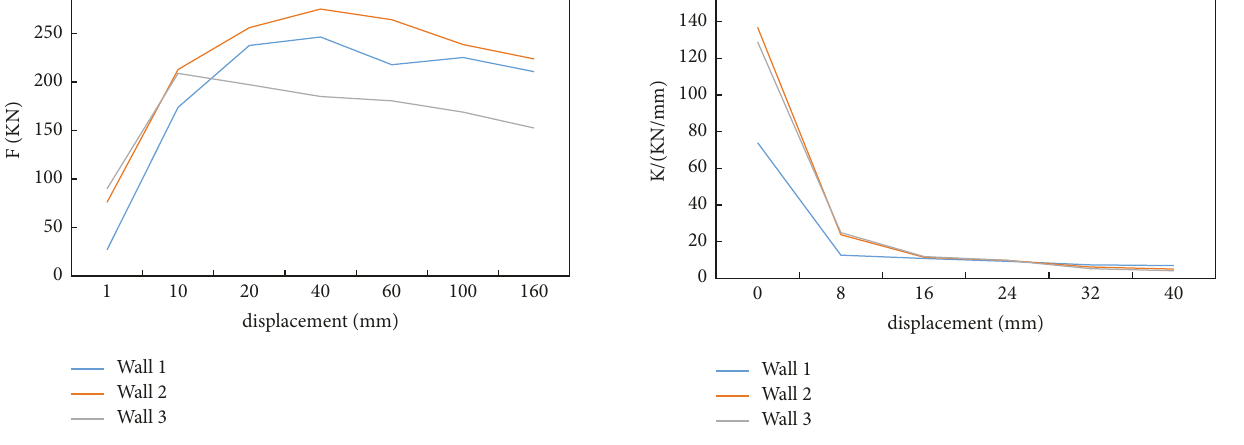
Figure 4: The wall load-displacement curve. Figure 5: Wall stiffness degradation